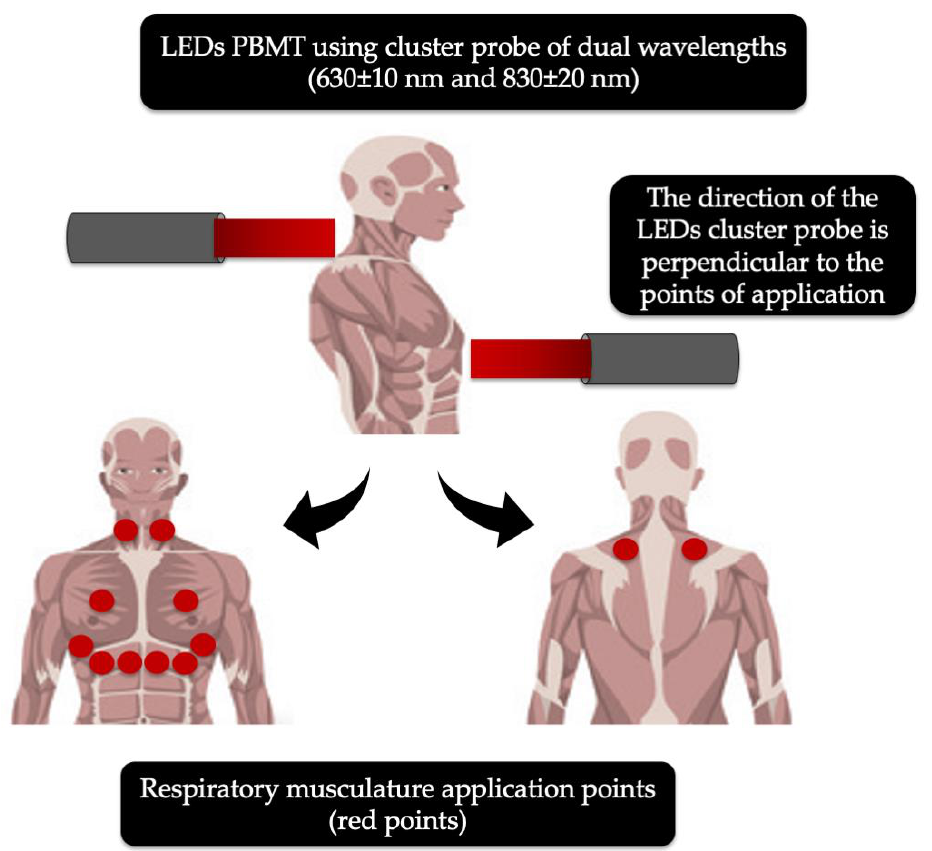
Figure 2. Modified schematic description of the respiratory musculature application points (red dots) for light-emitting diodes (LEDs) photobiomodulation (PBM) irradiation with 69 clustered head probe: 35 red ( λ 630 ± 10 nm) and 34 of near-infrared ( λ 830 ± 20 nm) in the management of COPD-19 [119].